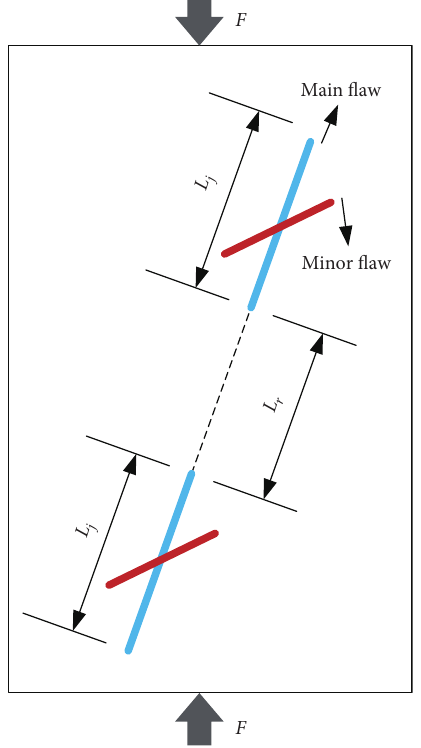
Figure 5: A schematic diagram of joint persistency. Table 3: List of k